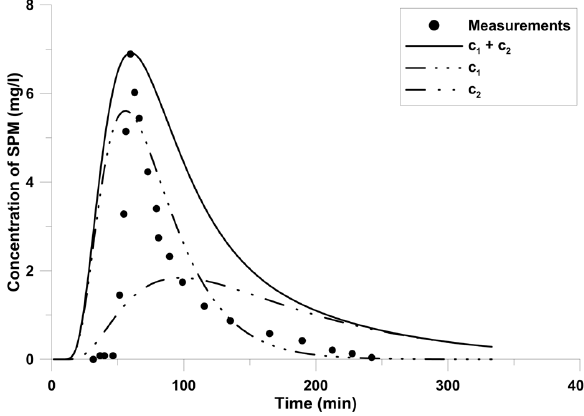
Figure 11. Calculated and measured variation in SPM concentration with time for the first Fig. 11. Calculated and measured variation in SPM concentration event in the Agnesberg landslide using the combined effect of two different sediment sizes with time for the first event in the Agnesberg landslide, using (coarse and fine silt). the combined effects of two different sediment sizes (coarse and fine